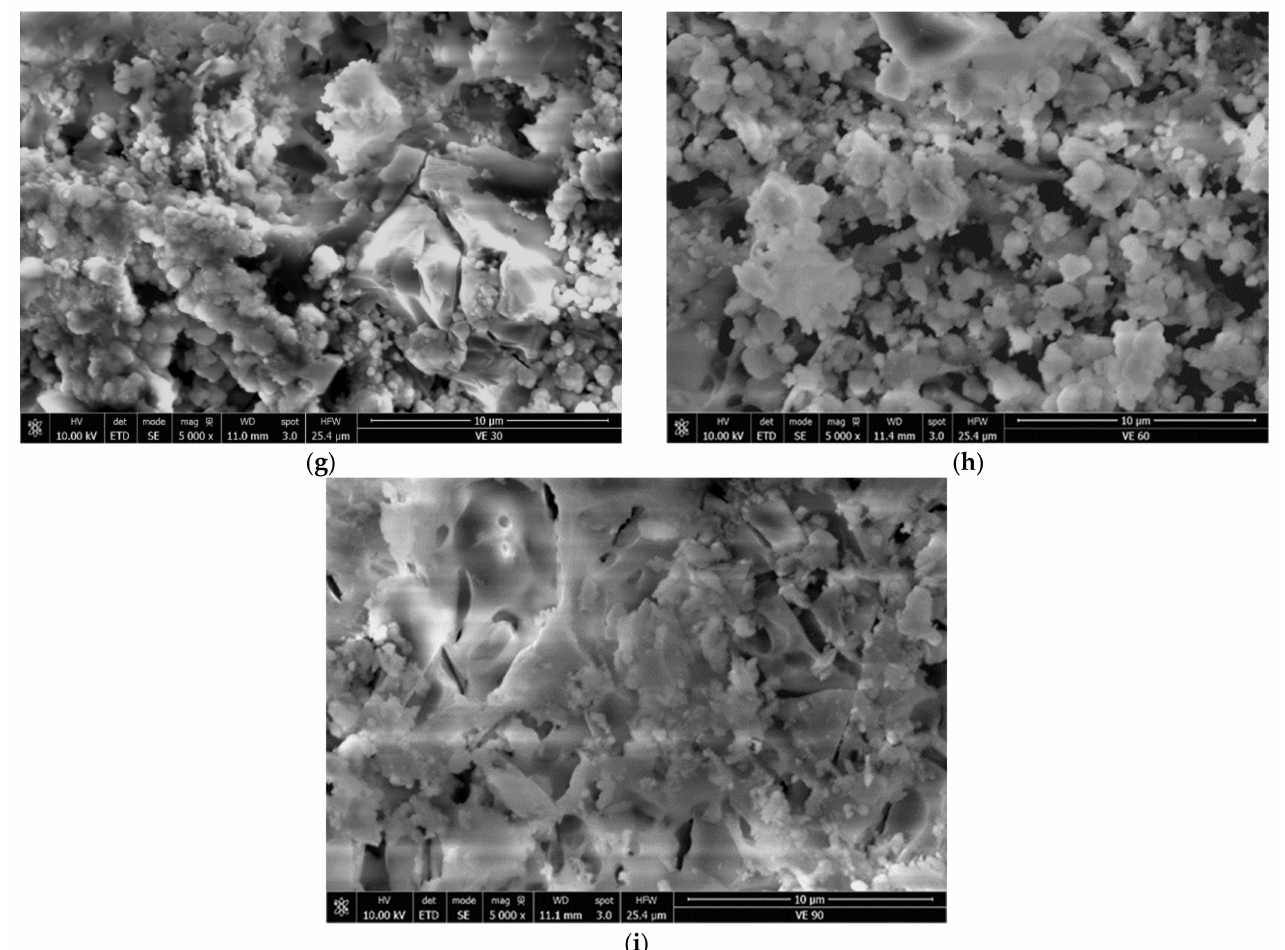
Figure 3. Scanning electron images of the representative etched sample. Ceramic crystals were visible following the removal of the glassy phase ( × 5000). ( a ) Sample of EX: 9.5% HF for 30 s; ( b ) sample of EX: 9.5% HF for 60 s; ( c ) sample of EX: 9.5% HF for 90 s; ( d ) sample of EP: 9.5% HF for 30 s; ( e ) sample of EP: 9.5% HF for 60 s; ( f ) sample of EP: 9.5% HF for 90 s; ( g ) sample of VE: 9.5% HF for 30 s; ( h ) sample of VE: 9.5% HF for 60 s, and ( i ) sample of VE: 9.5% HF for 90